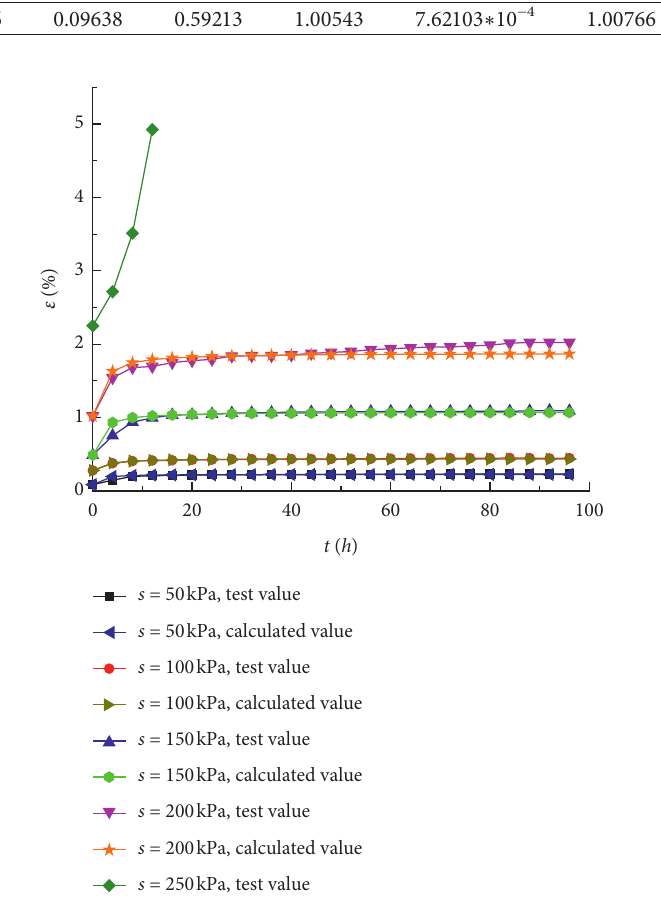
Figure 12: Contrast figures between calculated values and experimental